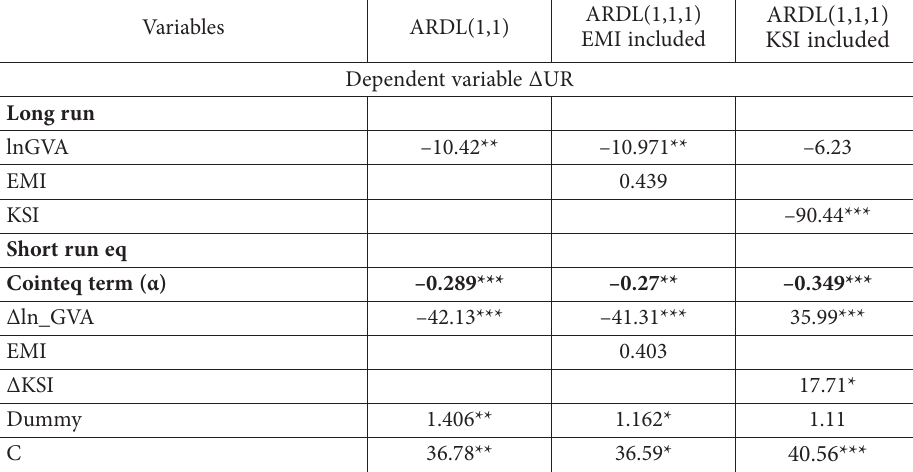
Table 5. Long run and short run relation between GVA and UR in Construction